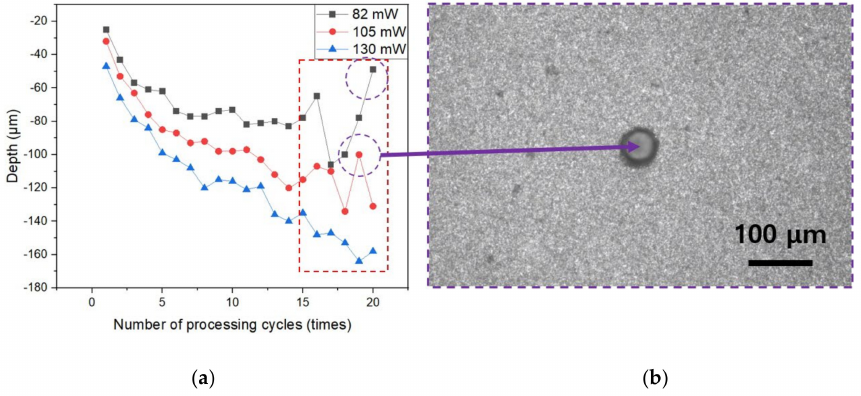
Figure 4. ( a ) Comparison of processing hole depth according to laser power and number of processing cycles; ( b ) observation image of molten material inside the processing hole for the outlier in ( a